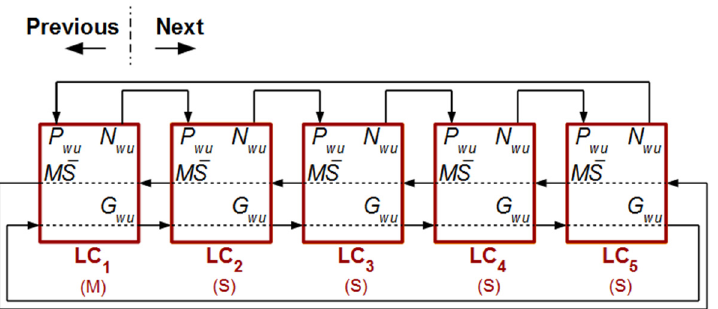
Figure 4. Daisy-chain topology of the inter-LC communications aims to manage the enabling or